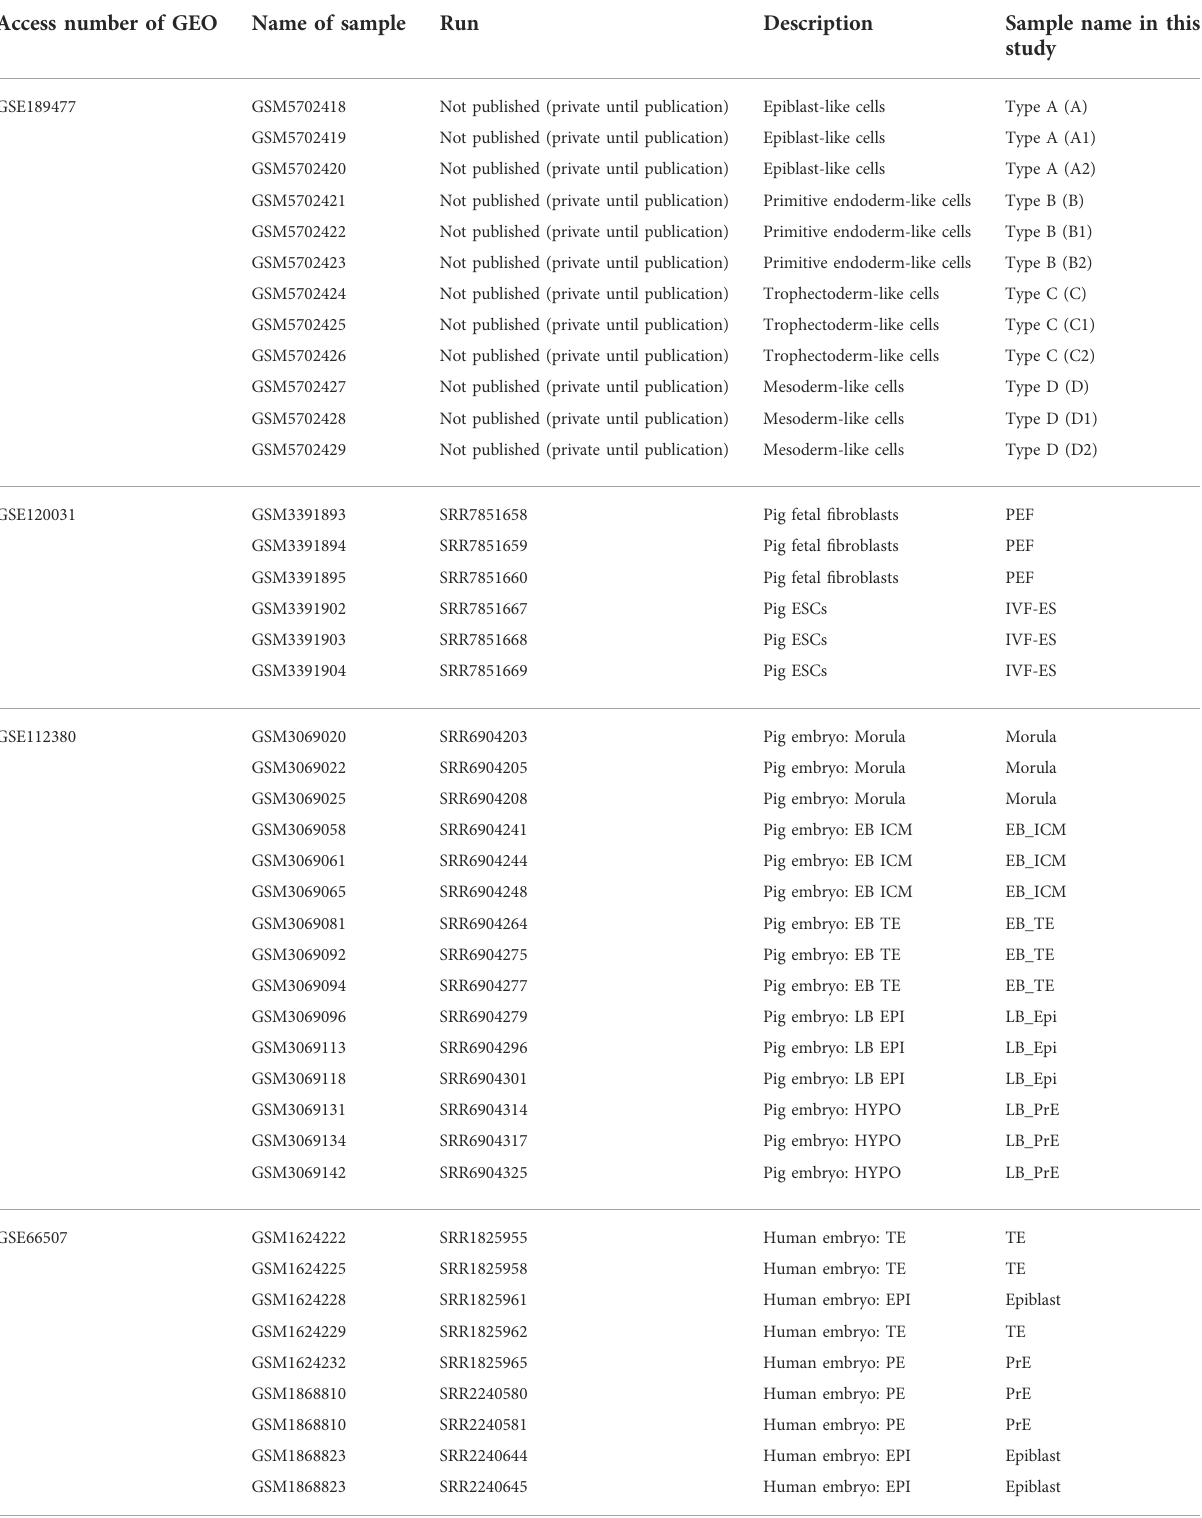
TABLE 3 List of RNA-seq